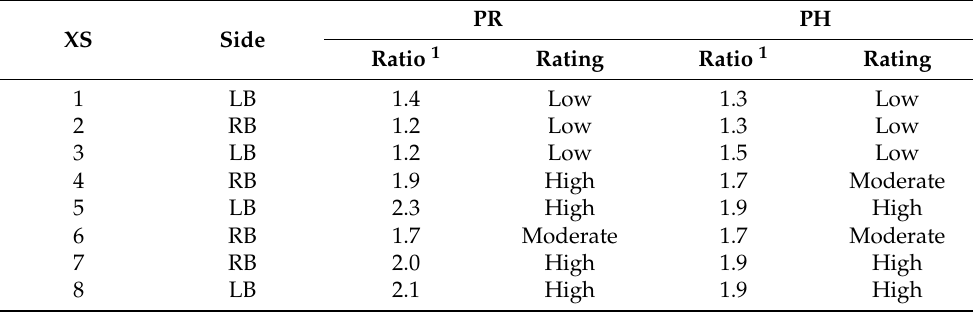
Table 4. Near-bank stress (NBS) ratings at the chosen cross-section for the Post-Restoration (PR) and Post-Hurricane (PH)